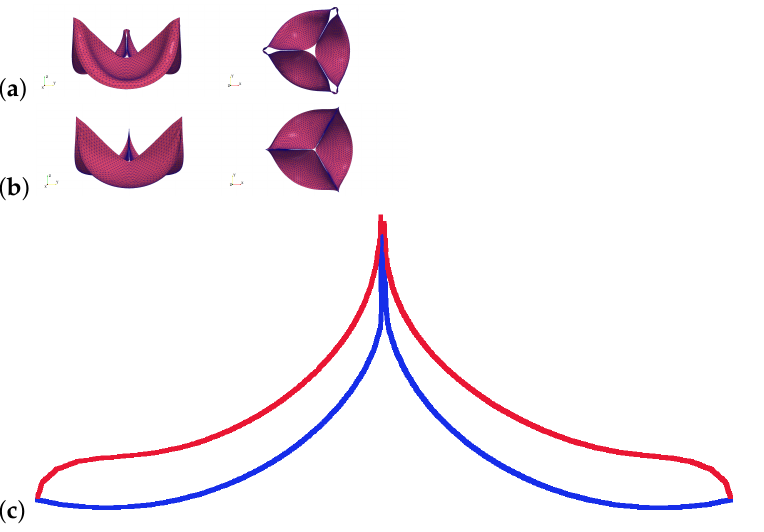
Figure 9. Mid-surface positions of the neo-Hookean ( E = 1 MPa) cusps with 0.5 mm thickness: ( a ) shell-based coaptation, ( b ) membrane-based coaptation, ( c ) trace of two leaflets on the cut plane distanced from the aortic center by 5 mm; shell-based curve (red) and membrane-based curve